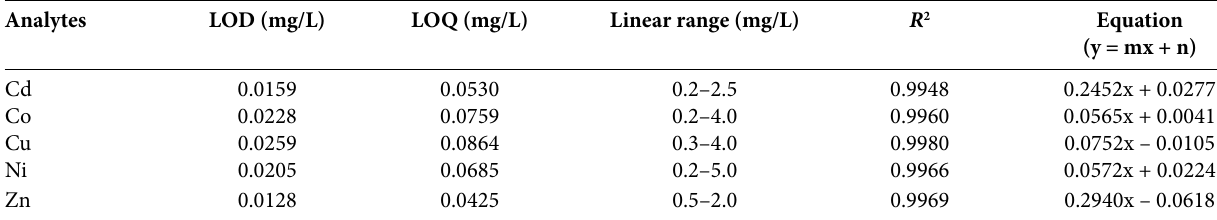
Table 3. Analytical figures of merit for Cd, Co, Cu, Ni, and Zn Analytes